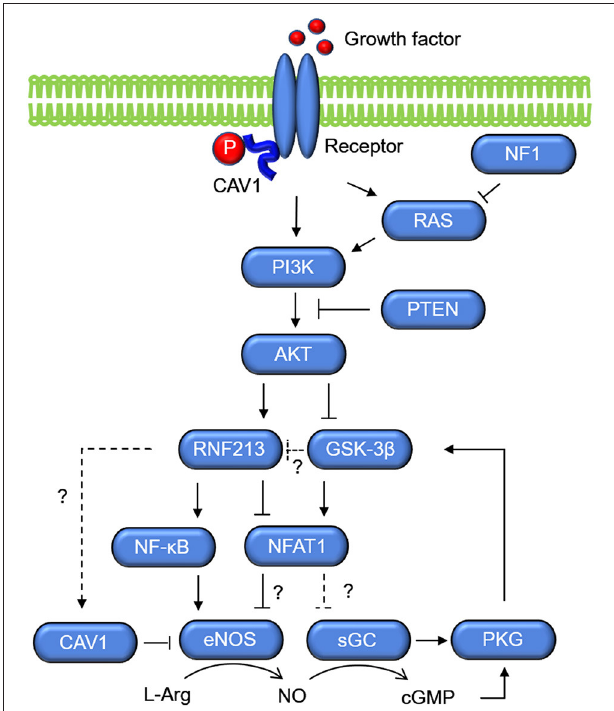
FIGURE 4 | Molecular networks of RNF213 and GUCY1A3 (sGC). Growth factors activate PI3K/AKT, which upregulate the expression of RNF213 and eNOS. Activation of PI3K/AKT leads to inactivation of GSK-3 β , which increases degradation of NFAT1 by the proteasome possibly via ubiquitination by RNF213. As opposed to the Ca + /Calmodulin/NFAT1 signaling shown in Figure 3 , NFAT1 is assumed to suppress eNOS expression in the context of PI3K/AKT. GSK-3 β , glycogen synthase kinase-3 β ; PKG, protein kinase G; sGC, soluble guanylate